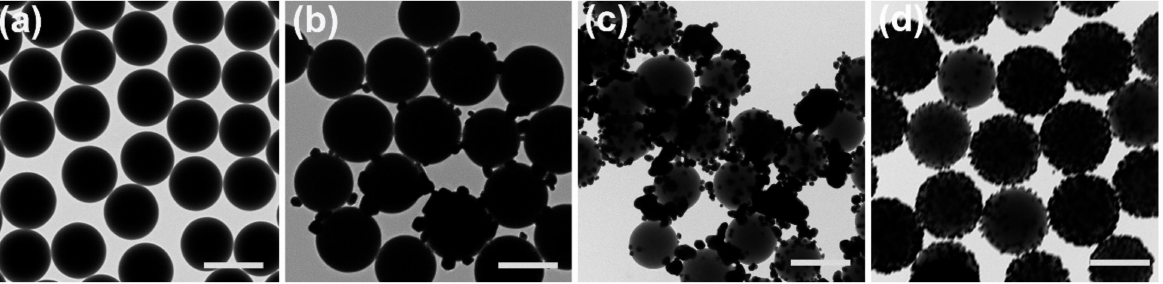
Figure 2. TEM images of SiO 2 and SiO 2 @Ag nanospheres substrate with different samples: ( a ) S0, ( b ) S1, ( c ) S2, and ( d ) S3, scale bar 500